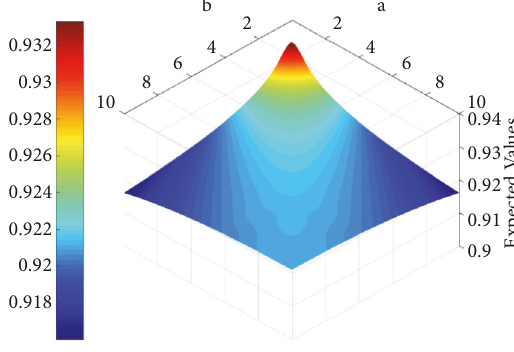
̃̃1) Figure 5: 𝐷(𝑅 3 − of Α 3 based on IT2FWPHM operator.